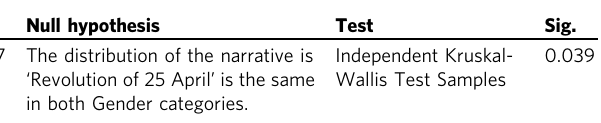
Table 16 Non-parametric Kruskal-Wallis test between genders concerning the rank scores given to the abbreviated narratives of the History of Portugal.